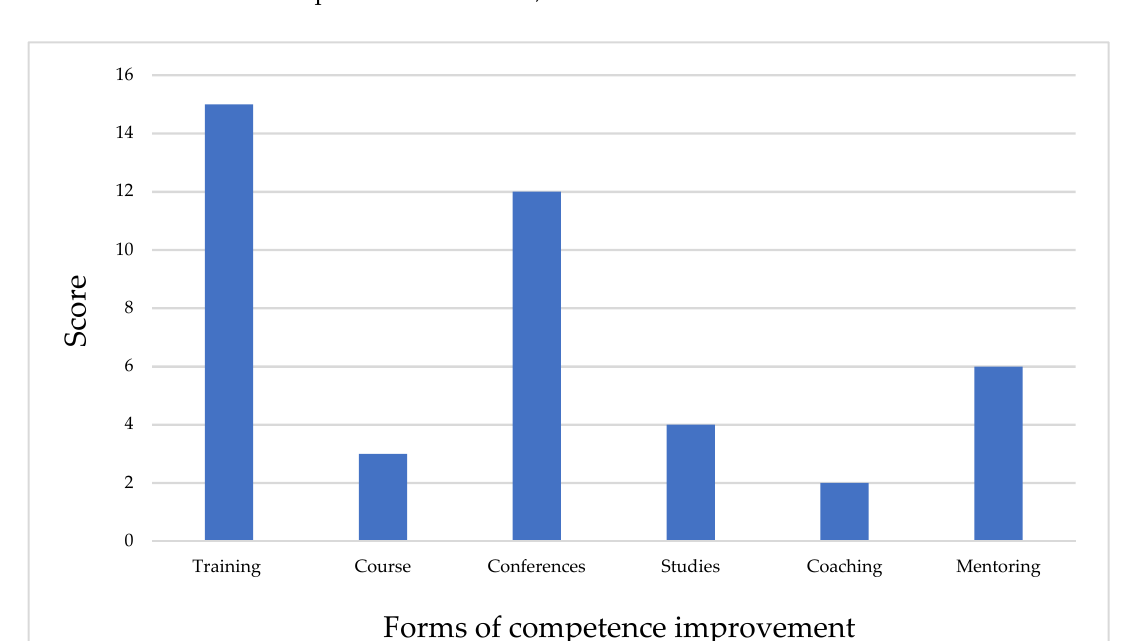
Figure 5. Forms of improving competences.